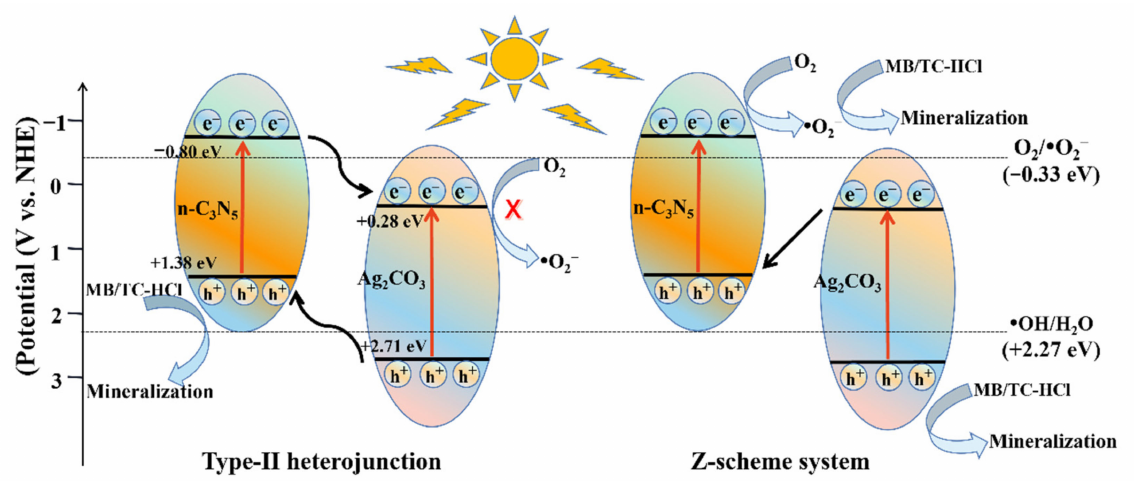
Figure 12. The proposed photocatalytic mechanism of MB and TC-HCl degradation by n- C 3 N 5 /Ag 2 CO 3